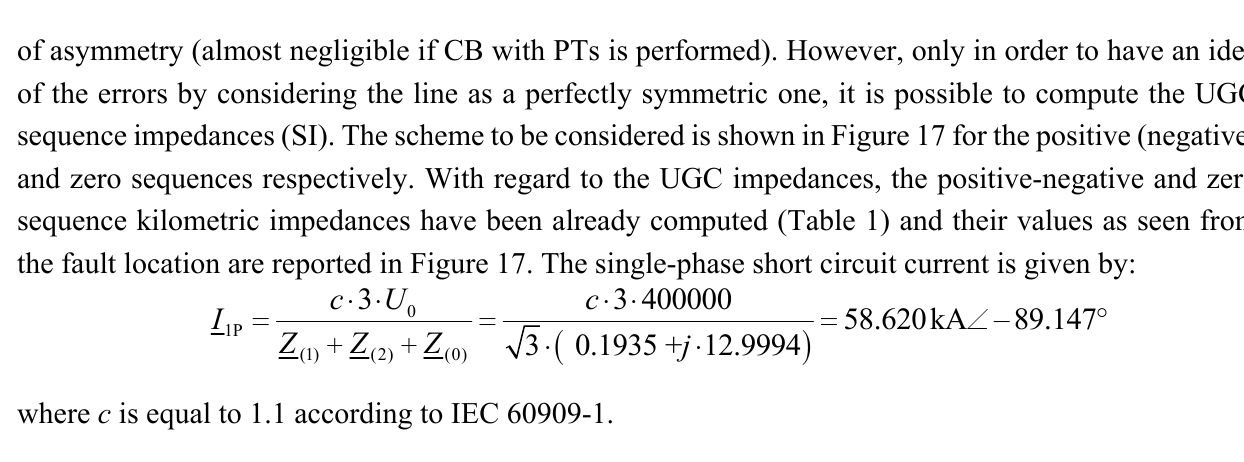
Figure 17. Faulted UGC: positive and zero sequence circuit for single-phase short circuit at